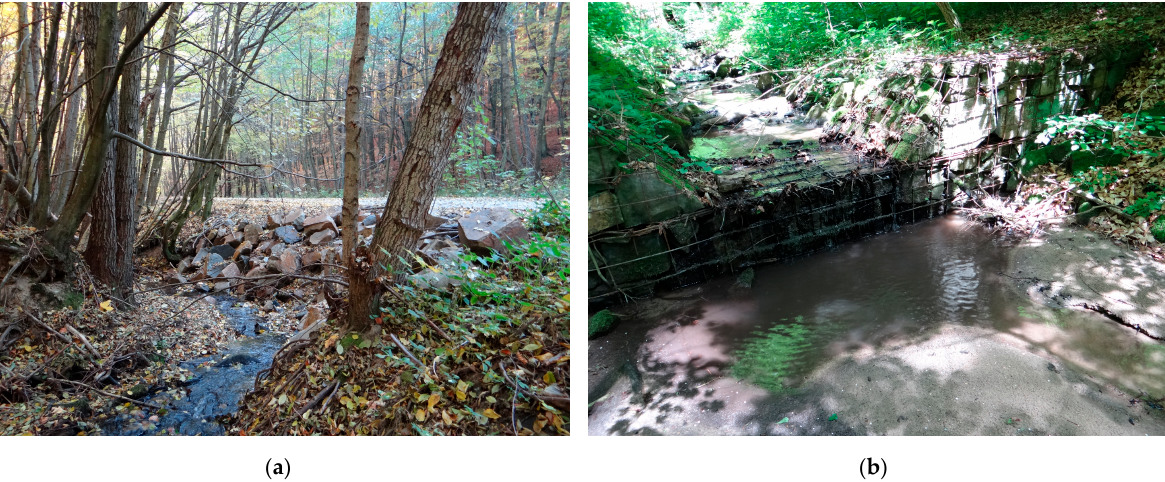
Figure 11. Forest engineering structures in watercourses with the occurrence of C. heros : ( a ) rein- forcement of the banks with stone riprap; ( b ) wire-stone sill.